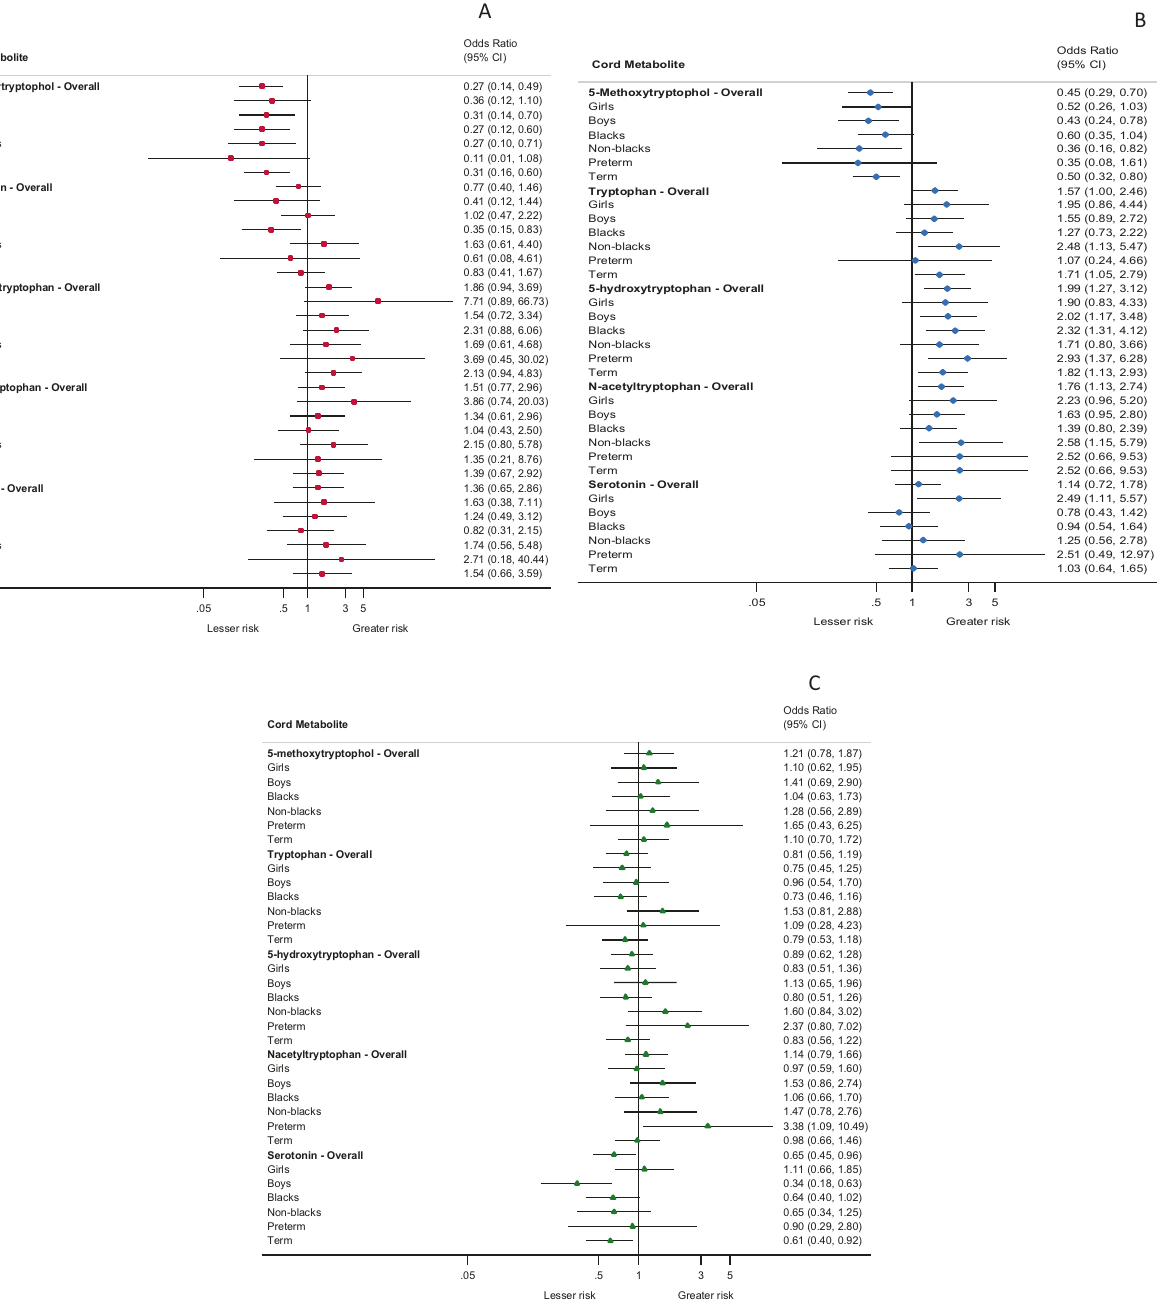
Fig. 3 Forest plots summarizing the subgroup analysis of association between select tryptophan metabolites with risk of ASD, ADHD and other DD. A Association between cord tryptophan metabolites and risk of ASD, overall and across sub-groups. B Association between cord tryptophan metabolites and risk of ADHD, overall and across sub-groups. C Association between cord tryptophan metabolites and risk of other DD, overall and across sub-groups. ASD autism spectrum disorder, ADHD attention-de fi cit/hyperactivity disorder, DD developmental